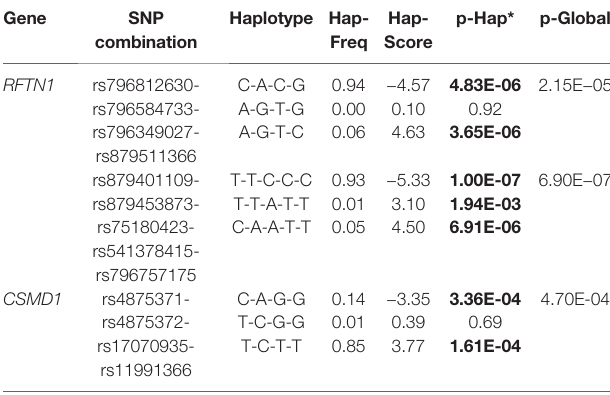
*Signi fi cant association after Bonferroni correction is shown in boldface type. The corrected P value thresholds after Bonferroni test for rs796812630-rs796584733- rs796349027-rs879511366, rs879401109-rs879453873-rs75180423-rs541378415- rs796757175, and rs4875371-rs4875372-rs17070935-rs11991366 were